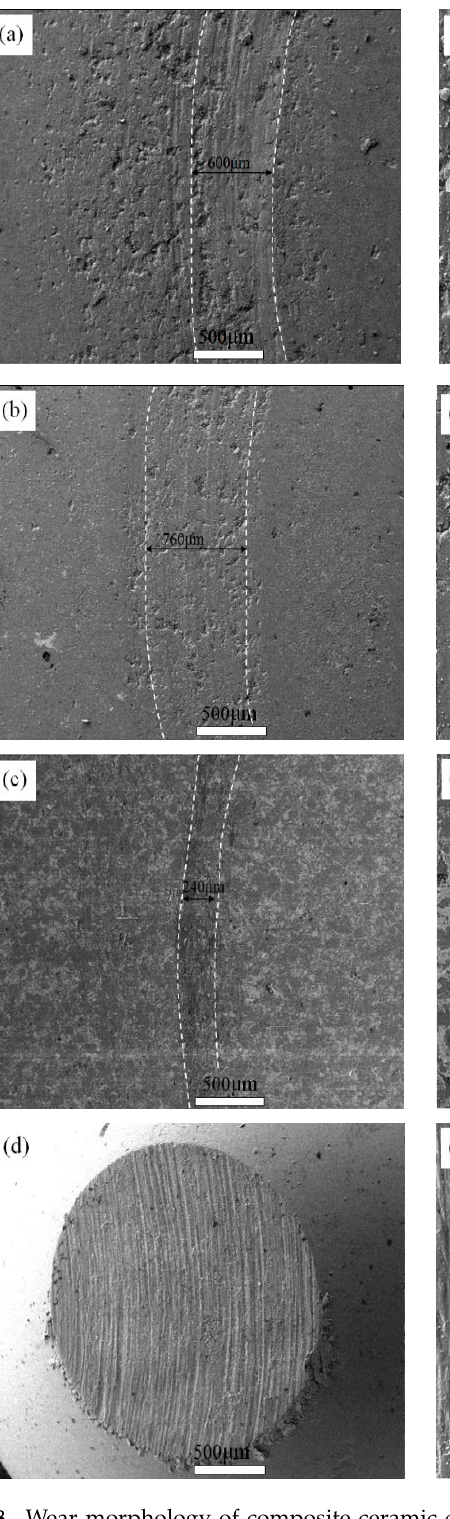
Figure 8. Wear morphology of composite ceramic coatings, ( a , e ) Ni60, ( b , g ) Ni60T, ( c , f ) Ni60TW, ( d , h ) 45# steel.